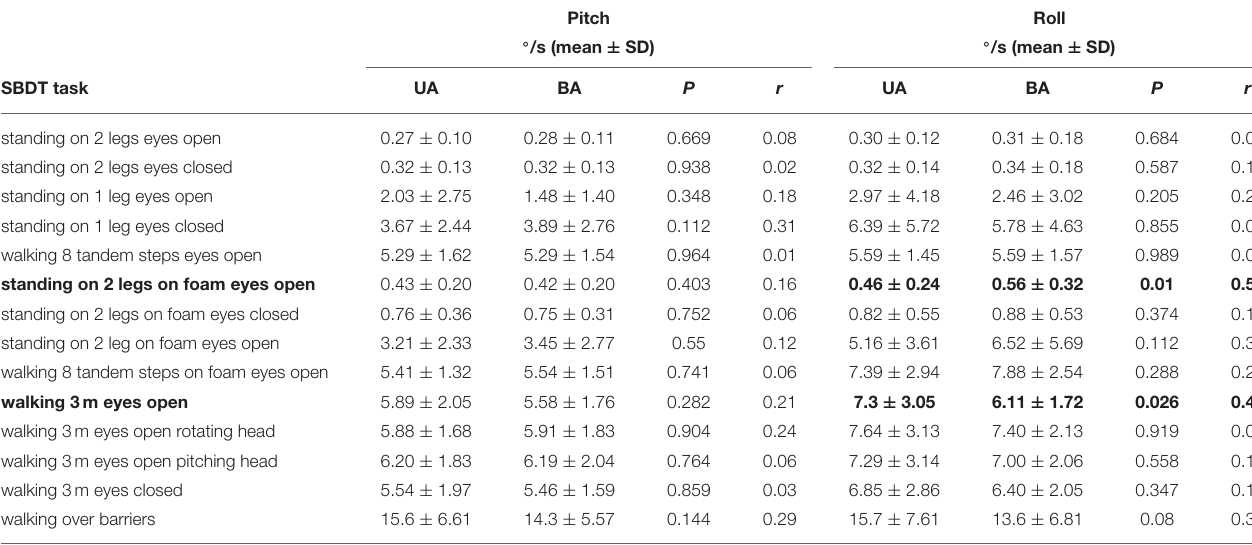
TABLE 1 | Trunk sway values measured with the VertiGuard-System in pitch and roll plane. Pitch Roll ◦ /s (mean ± SD) ◦ /s (mean ± SD) SBDT task UA BA P r UA BA P r 0.27 ±